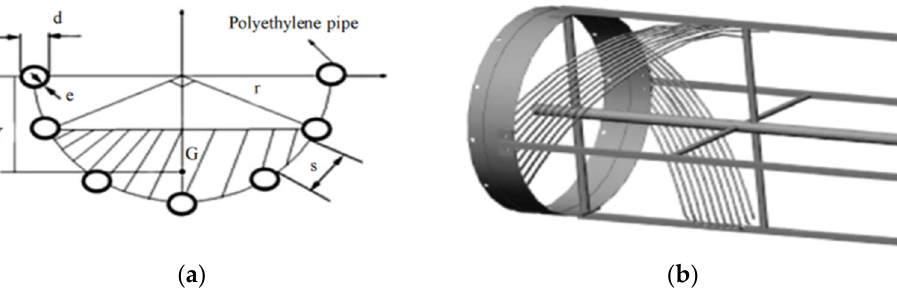
Figure 1. Gradation pipes cross-section at a semicircle of the helix (( a ) scheme; and ( b ) general form): d—the bar diameter; е —bar thickness; s—bar spacing; r—drum radius; G—center of gravity of the drum; and Y(cid:3553) —distance from the center of gravity to the center of the bar.